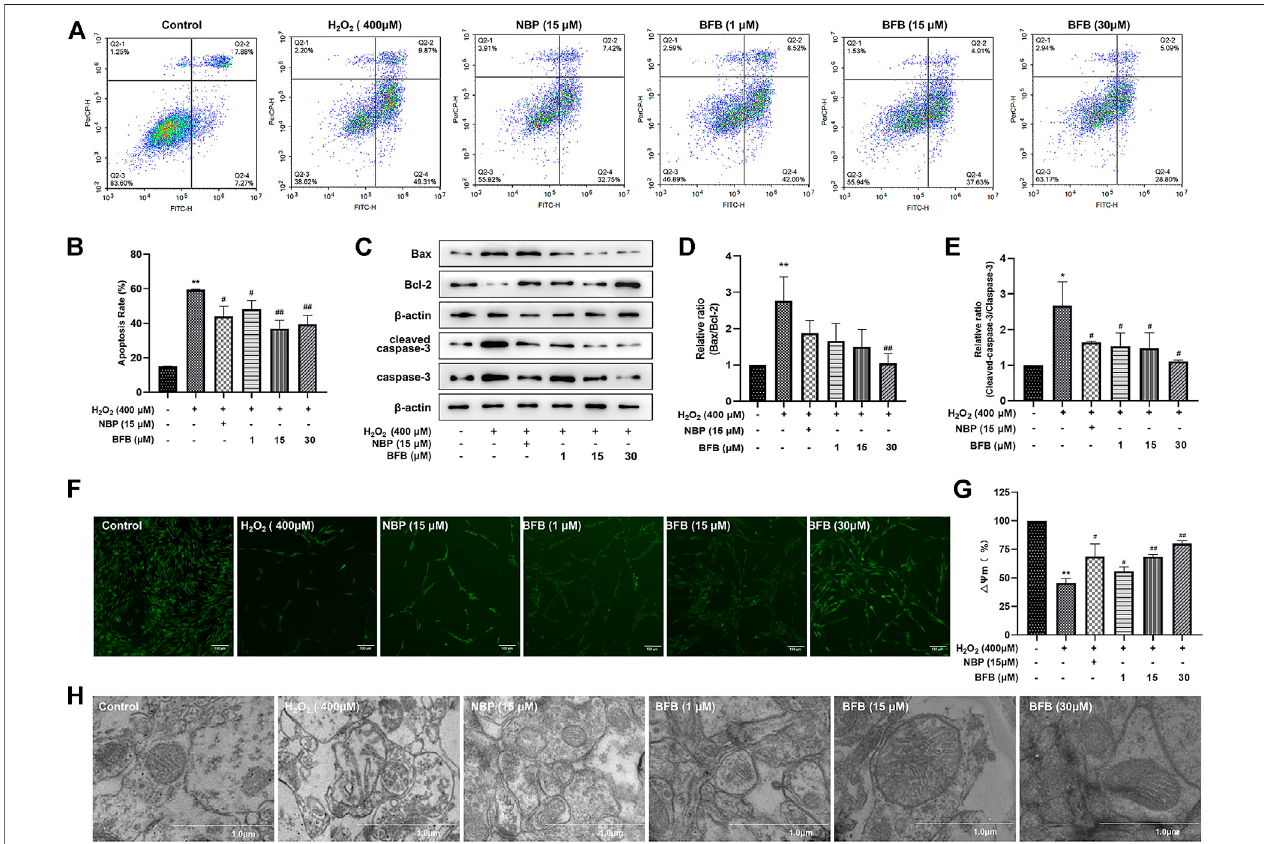
FIGURE3 | BFB inhibited apoptosis and abolished mitochondrial alterations ofH 2 O 2 -induced PC12 cells (A,B) FCM on apoptotic rate using Annexin V/PI staining (C) WBassayregardingBax,Bcl-2,capase-3,cleaved-capasethreeexpressionwithinPC12cellsexposedto400 µmH 2 O 2 and1,15,30 µmBFBorNBP(15 μ m).Bcl- 2 protein expression was signi fi cantly upregulated and Bax, capase-3 and cleave-capase 3 decreased within BFB-treated cells relative to H 2 O 2 -treated cells (D,E) WB assay on Bax/Bcl-2 and cleaved-capase 3/capase-3 ratio. Ratio of H 2 O 2 group increased compared with Control group, but BFB partially recovered this expression ratiofrom upregulation (F) Typical images displaying mitochondrial stainingunder diverse conditions byusing fl uorescence microscopy (scalebar = 100 µm) (G) Bar graph presenting fl uorescence intensity, which indicated MMP, by using fl uorescence microplate reader (H) Typical images showing ultrastructure of mitochondria through TEM (scale bar = 1.0 µm). Arrows stand for mitochondria. The data were represented by mean ± SD of three separate assays. * p < 0.05, ** p < 0.01, versus control, # p < 0.05, ## p < 0.01, versus H 2 O 2 group. ▲ p < 0.05, ▲▲ p < 0.01, versus NBP